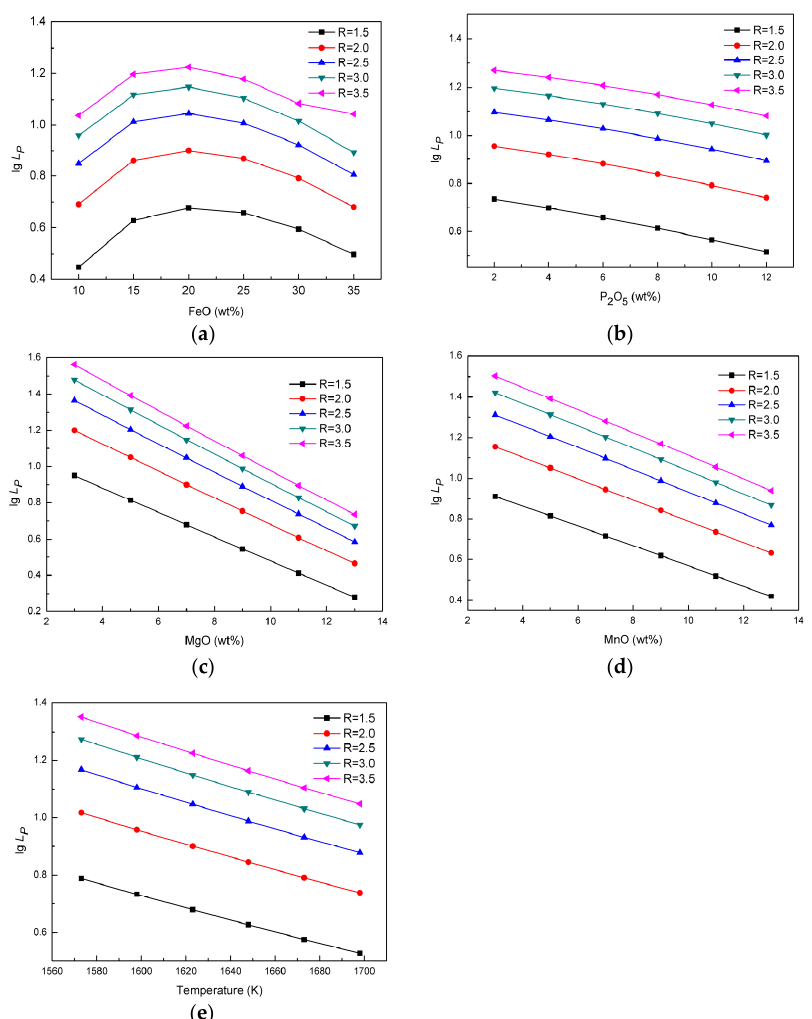
Figure 4. ( a ) The effect of Fe t O content on the equilibrium L p (In the condition that MgO content was 7%, MnO content was 5%, P 2 O 5 content was 5%, and the temperature was 1623 K). ( b ) The effect of P 2 O 5 content on the equilibrium L p (In the condition that MgO content was 7%, MnO content was 5%, Fe t O content was 20%, and the temperature was 1623 K). ( c ) The effect of MgO content on the equilibrium L p (In the condition that MnO content was 5%, Fe t O content was 20%, P 2 O 5 content was 5%, and the temperature was 1623 K). ( d ) The effect of MnO content on the equilibrium L p (In the condition that MgO content was 7%, Fe t O content was 20%, P 2 O 5 content was 5%, and the temperature was 1623 K). ( e ) The effect of temperature on the equilibrium L p (In the condition that MgO content was 7%, MnO content was 5%, Fe t O content was 20%, and P 2 O 5 content was 5%). It can be seen from Figure 4a–e that L p increased with the increase of slag basicity because the increase of basicity improved the ability to retain phosphorus in slag. From Figure 4a, when the Fe t O content was about 20%, and the L p was the largest. It should be noted that when the slag basicity was larger than 2.5, the phosphorus distribution ratio corresponding to 15% and 20% Fe t O content have little difference. However, when the slag basicity was smaller than 2.0, the dephosphorization effect of 20% Fe t O content was obviously better than that of 15% Fe t O content. The reason is that, on the one hand, Fe t O acts as oxidation and promotes dephosphorization. On the other hand, a large amount of Fe t O dilutes the concentration of CaO, which is not conducive to dephosphorization. Therefore, the ratio of (% CaO)/(% Fe t O) in the slag should be suitable to obtain a higher L p . From Figure 4b, the L p gradually decreased with the increase of P 2 O 5 content. For the dephosphorization reaction, P 2 O 5 is the product of the chemical reaction. It is not conducive to the dephosphorization reaction when the product of the chemical reaction increased. Therefore, the L p gradually decreased. The reason is that the increase of P 2 O 5 content increased the product of the dephosphorization reaction. From Figure 4c,d the L p gradually decreased with the increase of MgO and MnO contents. The reason was that the effect of MgO and MnO in the dephosphorization process was much less than CaO and FeO, which directly participated in the reaction. The increase of MgO and MnO content diluted CaO and FeO content. In the actual production process, both MgO and MnO are oxides that cannot be avoided, and their role is not necessarily negative. An appropriate content range of these oxides can reduce the melting point of the slag, improve the fluidity of the slag, improve the melting of lime and play a beneficial role in dephosphorization. Therefore, the MgO and MnO contents need to be in an appropriate range to promote dephosphorization. From Figure 4e, the L p decreased with the increase of temperature because dephosphorization is an exothermic reaction. From the thermodynamic view, low temperature is beneficial to dephosphorization. In the actual production process, slag formation is difficult when the temperature is low. It is necessary to coordinate the relationship between low-temperature dephosphorization and forming slag. The slag-forming route of dephosphorization was obtained by the above theoretic calculation, as shown in Figure 5. From Figure 5, it was suggested to select a slag-forming route with the L p rising rapidly and the slag melting point rising slowly, which is good for slagging rapidly and formation slag beneficial for dephosphorization. In the early stage